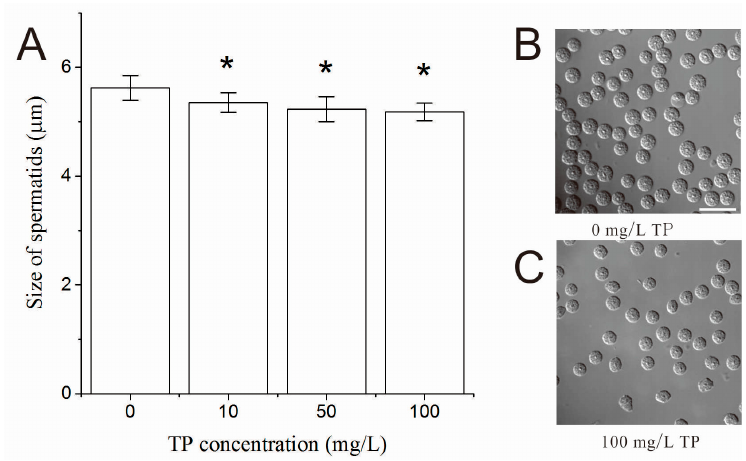
Figure 6. Effects of TP on the size of spermatids: ( A ) the size of spermatids per nematode exposed to TP for 4 h; ( B ) the spermatids morphology of the control group after 6 h of exposure; and ( C ) the spermatids morphology of nematodes exposed to 100 mg/L TP after 6 h of exposure. Scale bar is 15 µm. TP, Triptolide. Bars represent means ± SEM. * p < 0.05 vs. the control group.